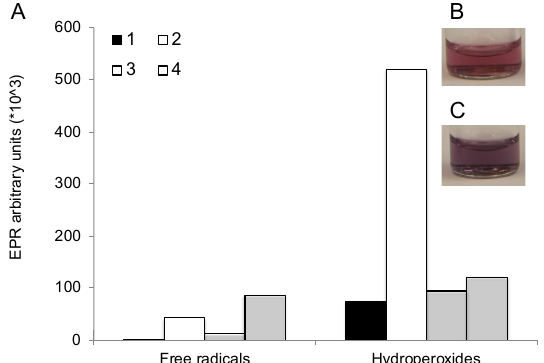
Figure 9. ( A ) Free radicals and hydroperoxides content in the regular (1,2) and N 2 purged (3,4) stock solutions of 6.3% w / w F127 (1,3) and the reaction mixtures of these solutions with HAuCl 4 (2,4). ( B , C ) Images of GNP dispersions formed in ( B ) regular and ( C ) N 2 purged solutions of 6.3% w / w (5 mM) F127. The F127 solution was purged with N 2 for 5 min before mixing with HAuCl4, and then the reaction was carried in a closed vessel. In all cases, the reaction mixtures were incubated for 2 h (unless shown 1 h) at 45 °C .